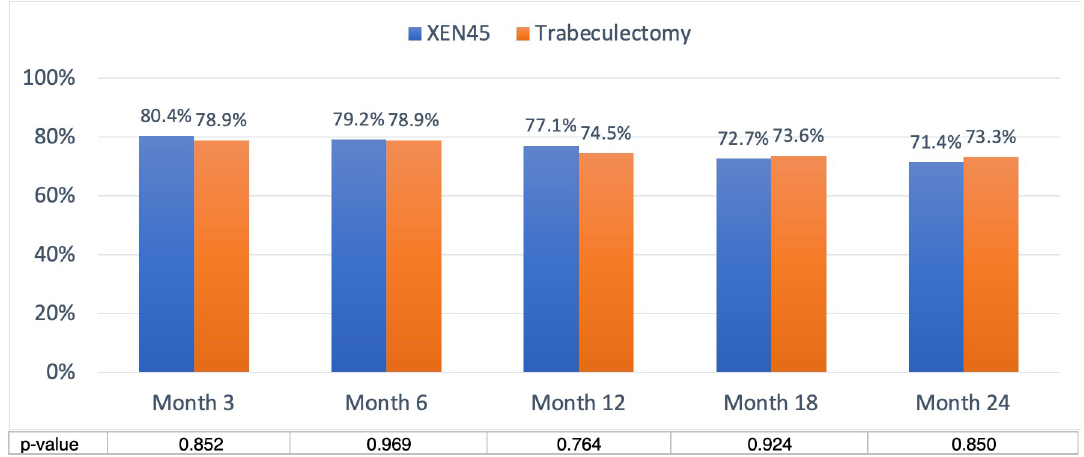
Fig 4. Overall success was defined as postoperative IOP reduced � 20% from the preoperative baseline, with or without medications. Overall success of XEN implant and trabeculectomy were comparable at all timepoints. At month 24, the overall success was 71.4% and 73.4% respectively.